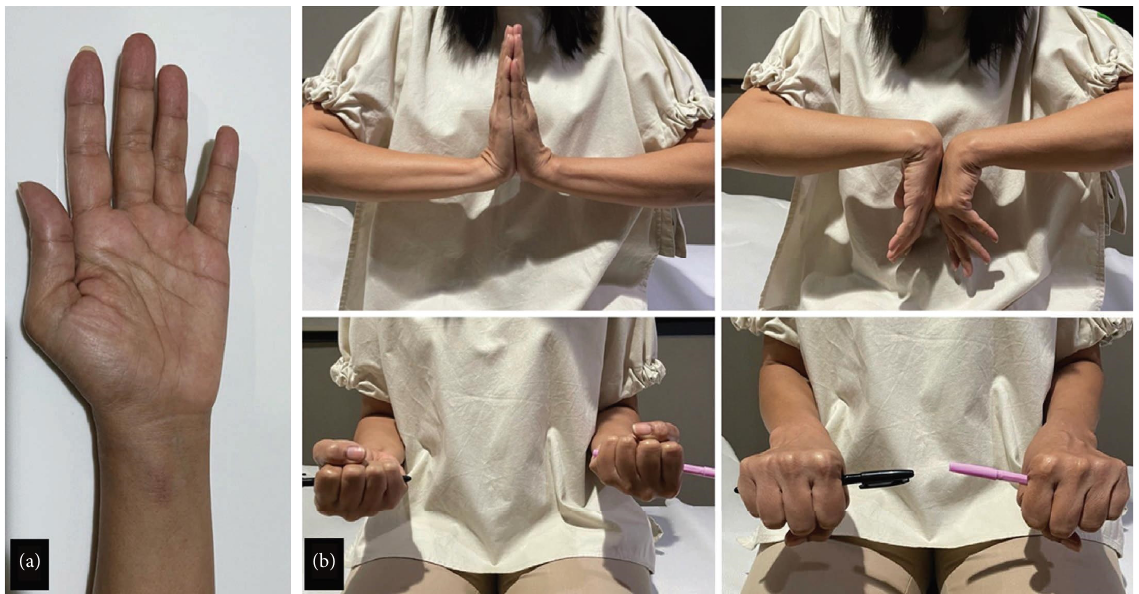
Figure 3: Clinical examination after six months of postoperative follow-up in case 1.